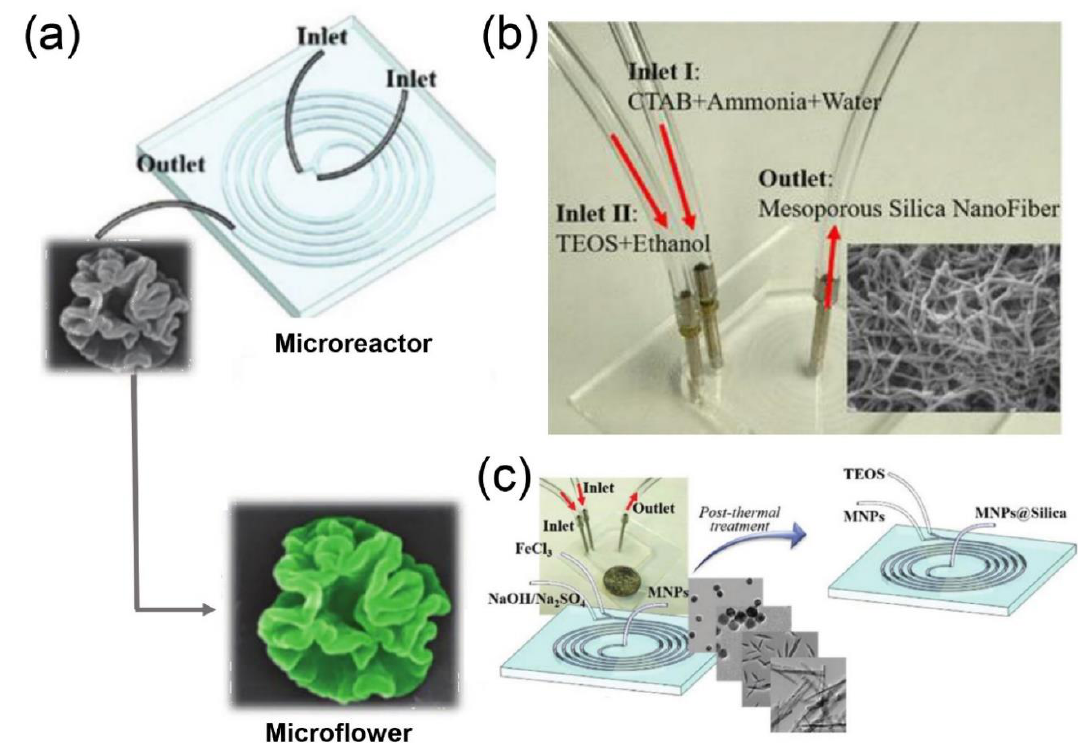
Figure 3. ( a ) Schematic illustration for the microfluidic synthesis of silica nanoflowers (reproduced from [93], with permission from the Royal Society of Chemistry, 2018). ( b ) Experimental setup for the microfluidic synthesis of silica fibers (reproduced from [30], with permission from the American Chemical Society, 2018). ( c ) Microfluidic synthesis of Fe 2 O 3 -SiO 2 nanomaterials for circulating tumor cell screening (reproduced from [32], with permission from the Royal Society of Chemistry, 2018).